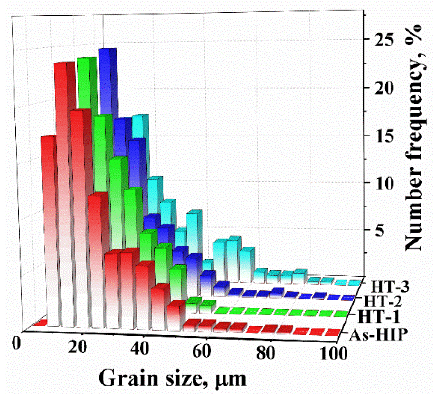
Figure 3. Grain size distribution for P/M superalloy FGH4107 specimens.